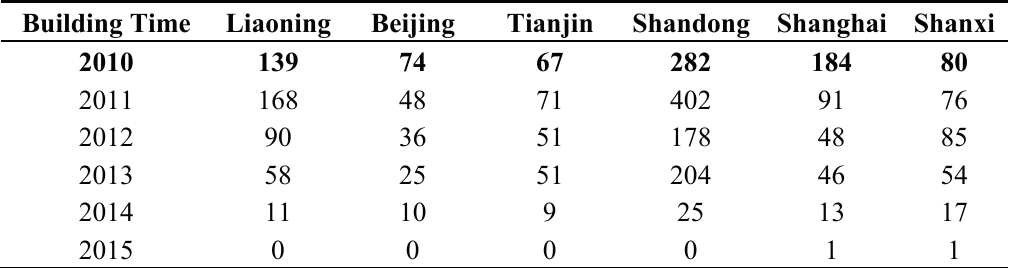
Table 5. Number of reserved geo-tagged web texts between 2010 and